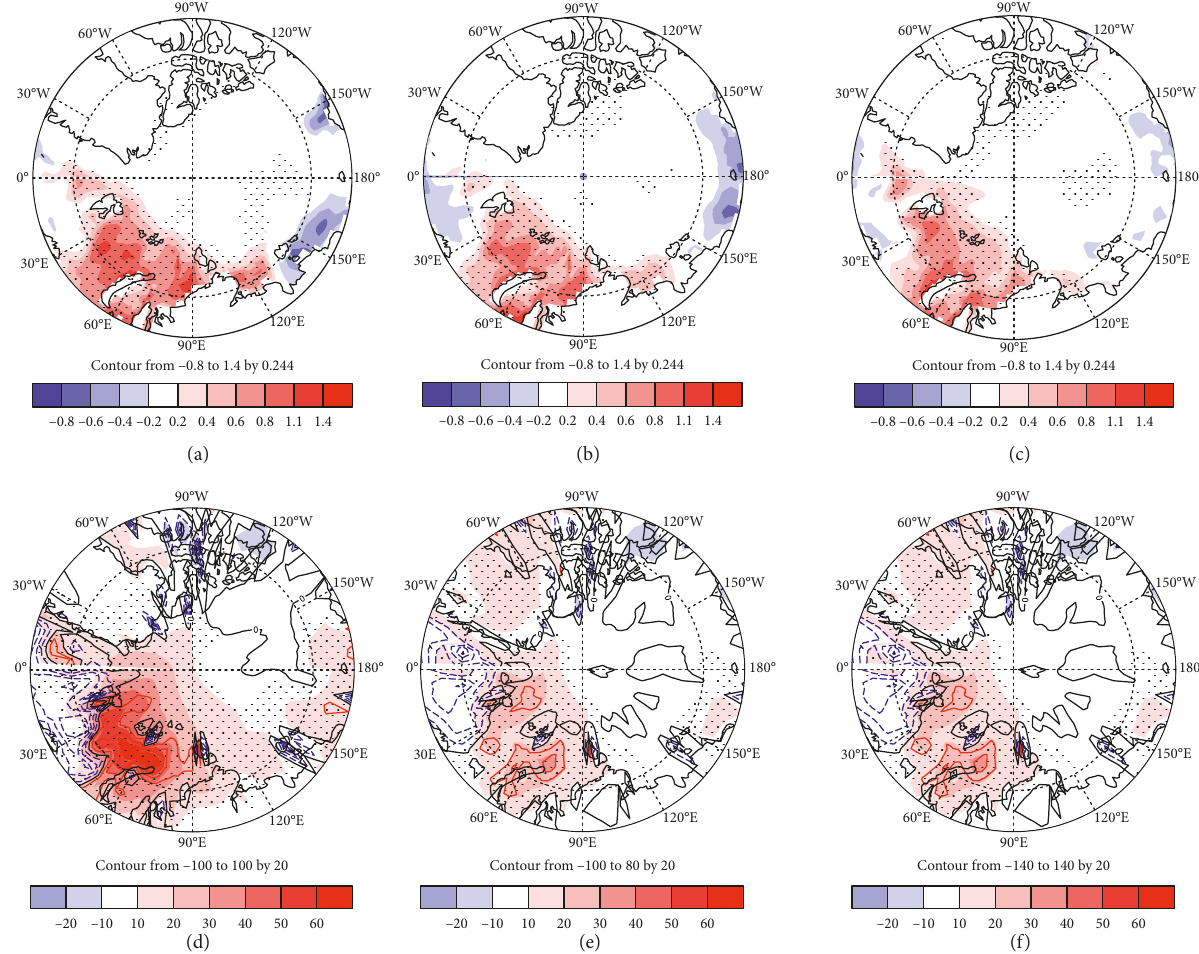
Figure 7: Composite differences for the SON mean upper ocean heat content (shaded) between selected low and high DBKI in September (a), October (b), and November (c) (unit: K). (d–f) The same as (a), (b), and (c) but for DJF mean upward longwave radial (shaded) and sensible+latent heat flux (contour) (unit: w · m − 2 ). The dotted areas denote the values that are statistically significant with significance exceeding 0.1 based on the results of t -tests for heat content in (a), (b), and (c) and longwave radiation in (d), (e), and